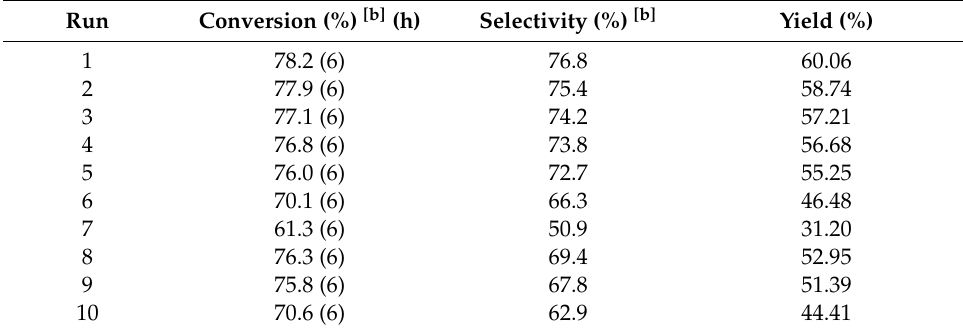
Table 3. The recycling of ZPS–PVPA–SO 3 H in epoxidation of soybean oil.